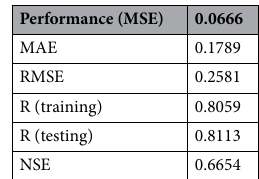
Table 13. Evaluation using BR